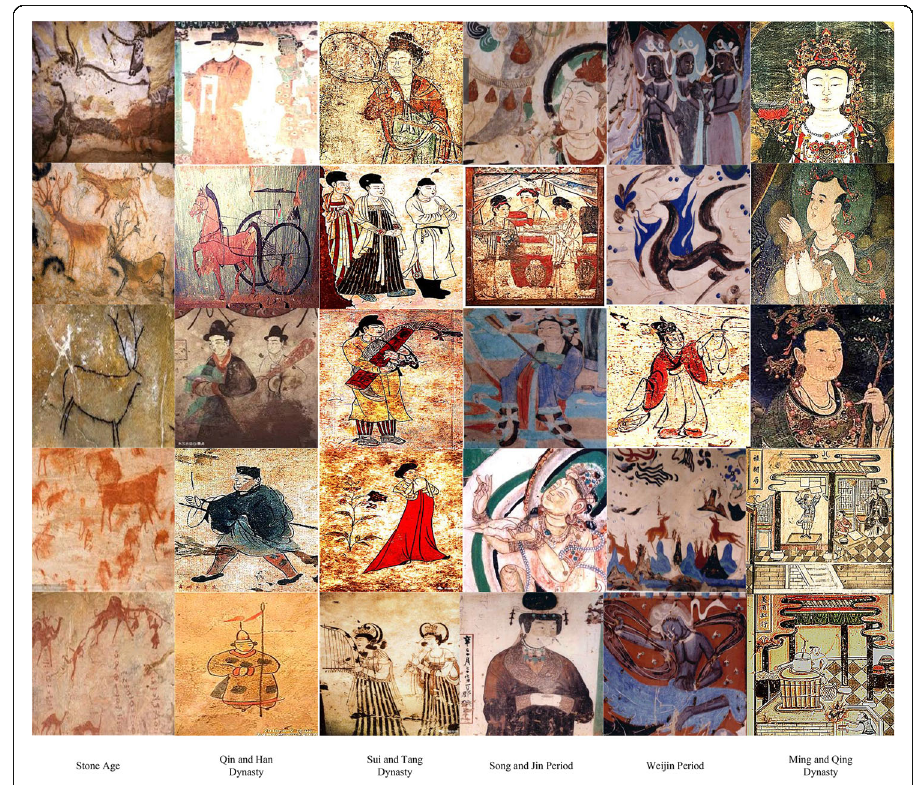
Fig. 4 Sample images of different